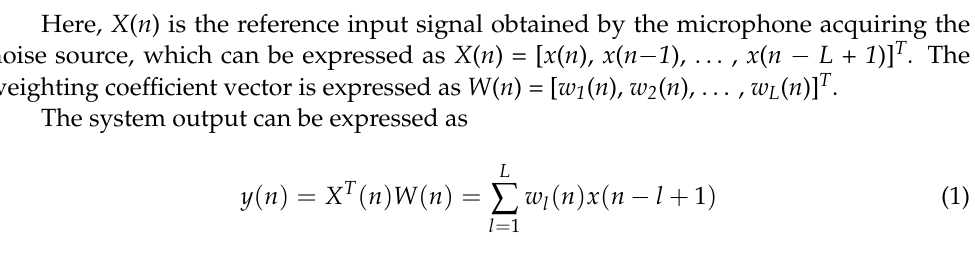
Figure 1. Block diagram of ANC algorithm: ( a ) Transversal filter; ( b ) ANC system.